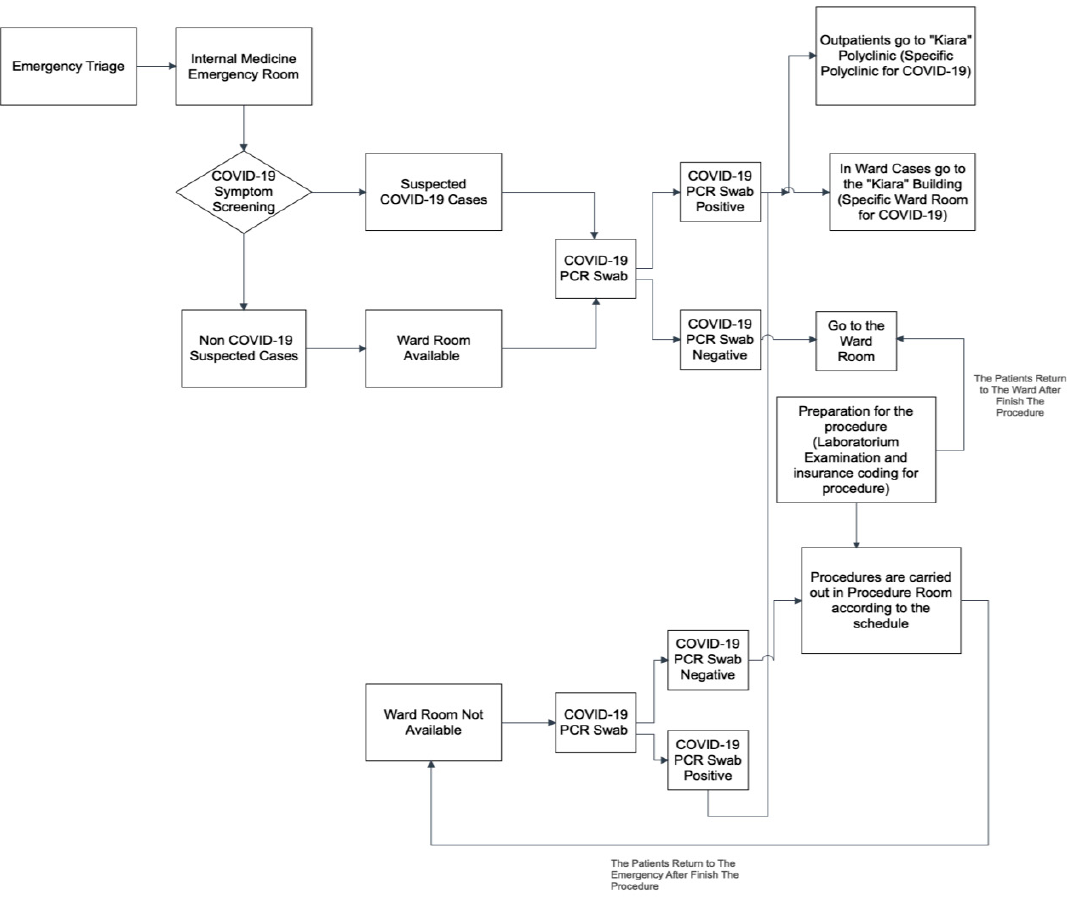
Figure 6. Entry Flow of Endoscopic Patients from the Emergency Room During the Pandemic.